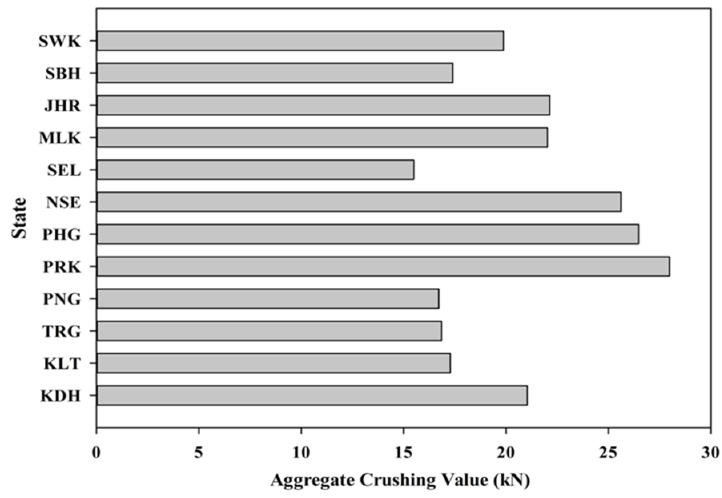
Figure 6. Aggregate crushing values for various states.